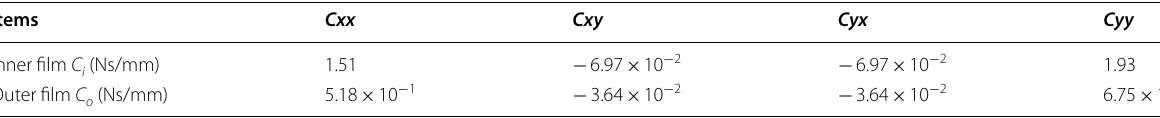
Table 3 Bearing damping coefficients Items